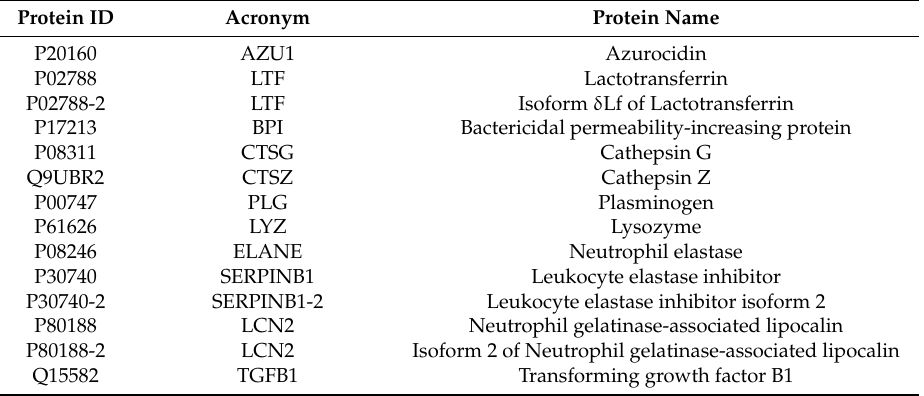
Table 4. Neutrophil- and leukocyte-associated factors in wound